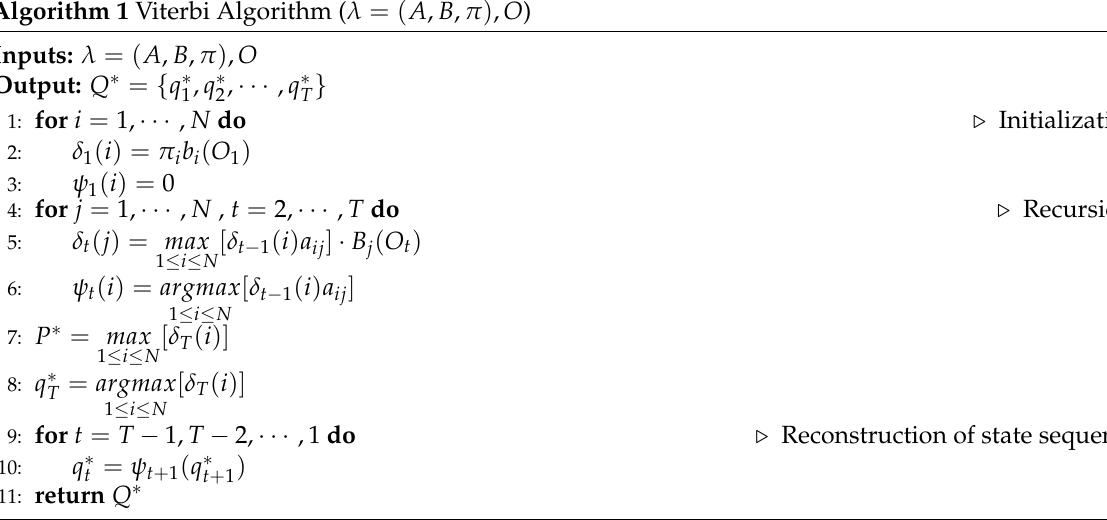
Algorithm 1 Viterbi Algorithm ( λ = ( A , B , π ) , O